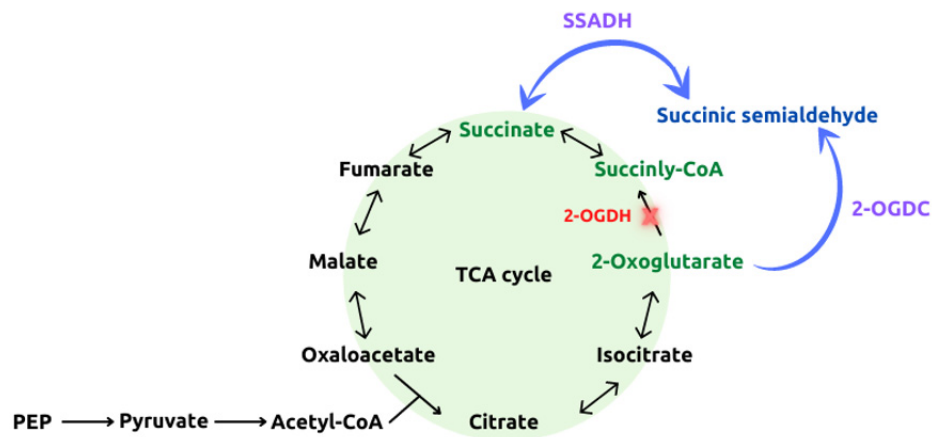
Scheme 1. Conversion of 2-oxoglutarate to succinate in the TCA cycle in cyanobacteria [10].